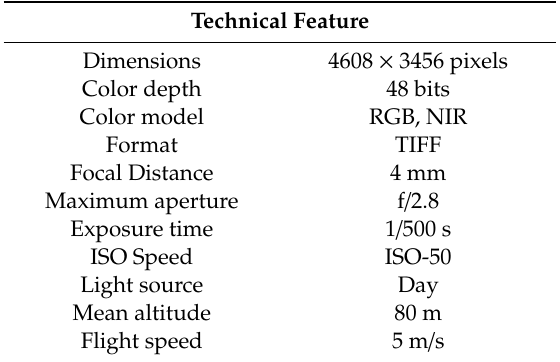
Table 1. Technical characteristics of images taken using the Unmanned Aerial Vehicle.